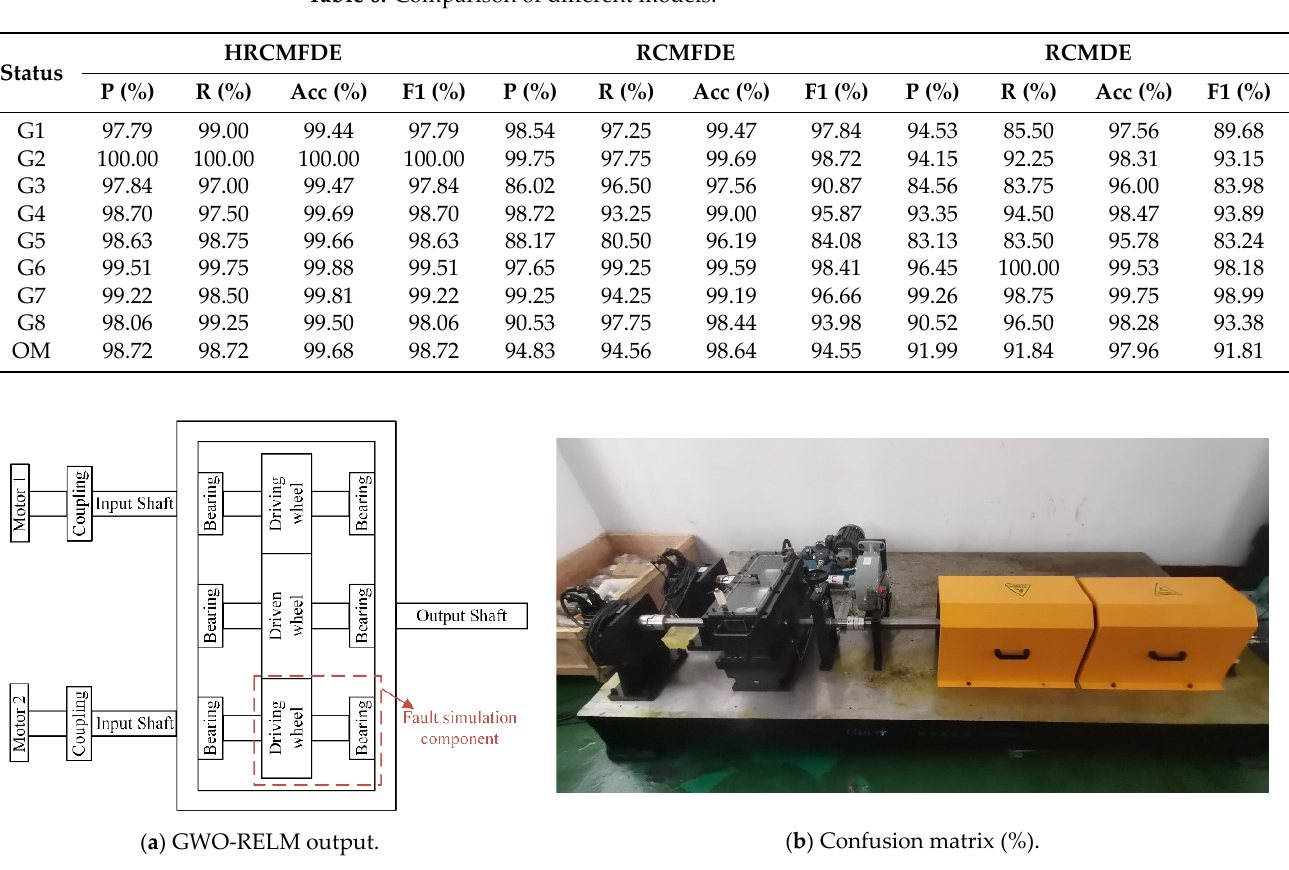
Table 6. Comparison of different models.